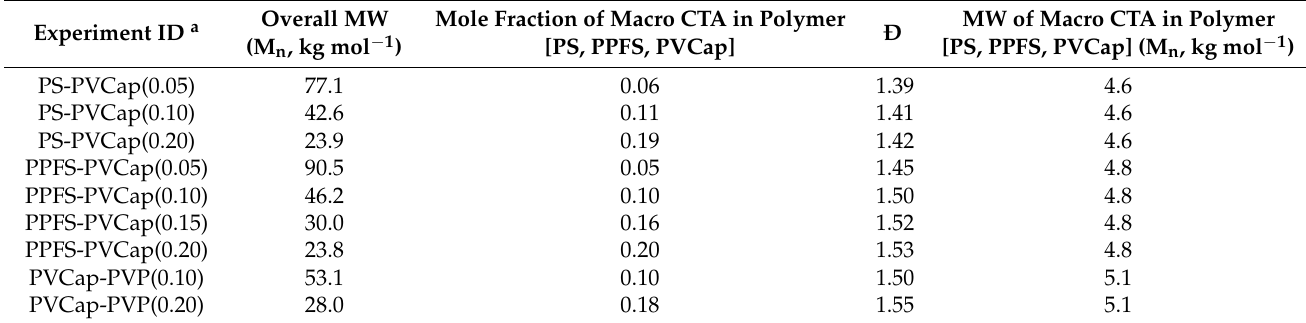
Figure 6. ( A ) Plots of the linearized conversion [ln(1 − X) −1 ] (X = conversion) versus time at 90 °C for PVCap, and 70 °C for PVP; ( B ) the dispersity (Đ) versus conversion (X); ( C ) the number average molecular weight (M N ) versus conversion (X) for the chain extension reaction. The apparent rate constants for the chain extension reactions of PS-PVCap, PPFS- PVCap, and PVCap-PVP were calculated to be 4.9 × 10 −3 min −1 , 3.9 × 10 −3 min −1 , and 2.5 × 10 −3 min −1 , respectively. Table 4 indicates the final molecular weights and dispersities of the block copolymer macrosurfactants synthesized. The macro-CTAs were chain-extended for varying reaction times following the kinetic curves shown in Figure 6 in order to achieve the desired mole fractions of the macro-CTA in the polymer. Table 4. Identification of the block copolymers synthesized for determination of critical micelle concentration (CMC) and kinetic hydrate inhibition